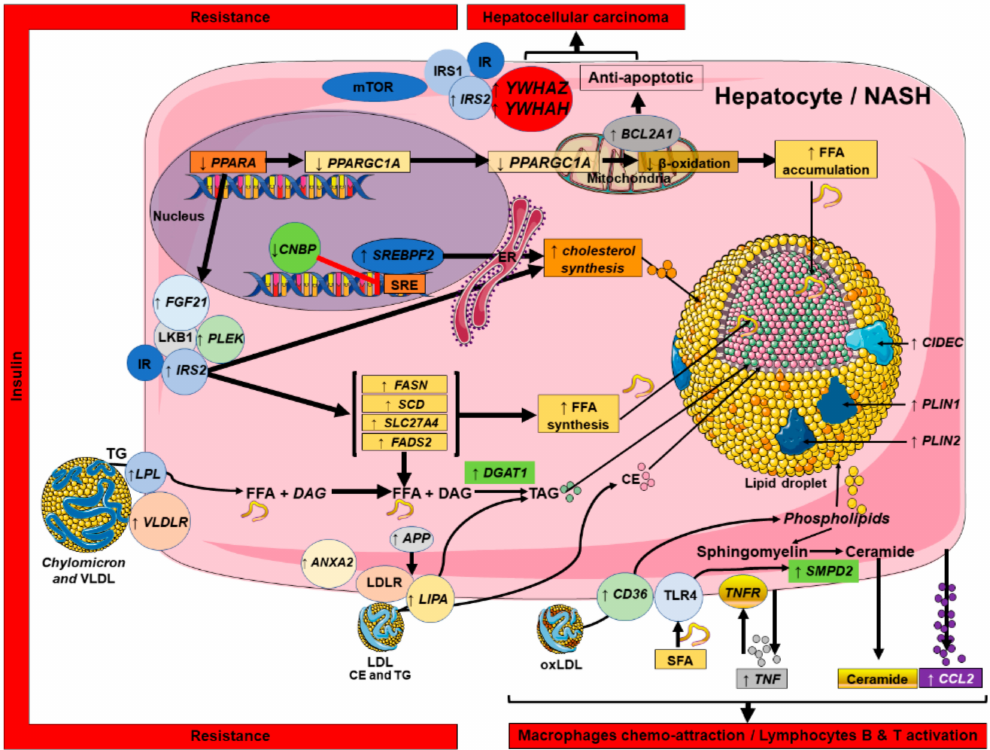
Figure 7. NASH canonical pathway defined based on the 25 genes that were found using text-mining analysis. Draw of pathophysiologic hypothesis connected to altered-lipid related genes expression in liver samples of NASH and associated to immunity, inflammation and liver pathogenesis